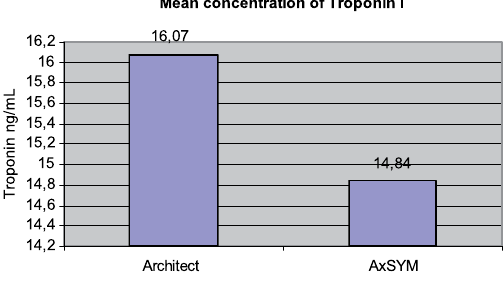
FIGURe 2. the comparison of troponin i in patient serum using different